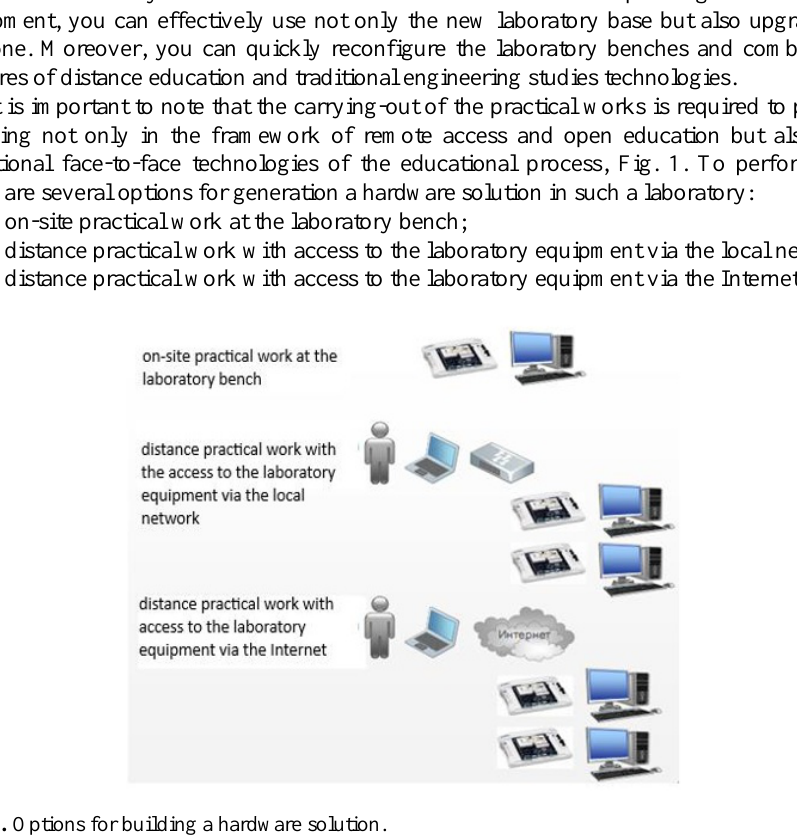
Fig. 1. Options for building a hardware solution.